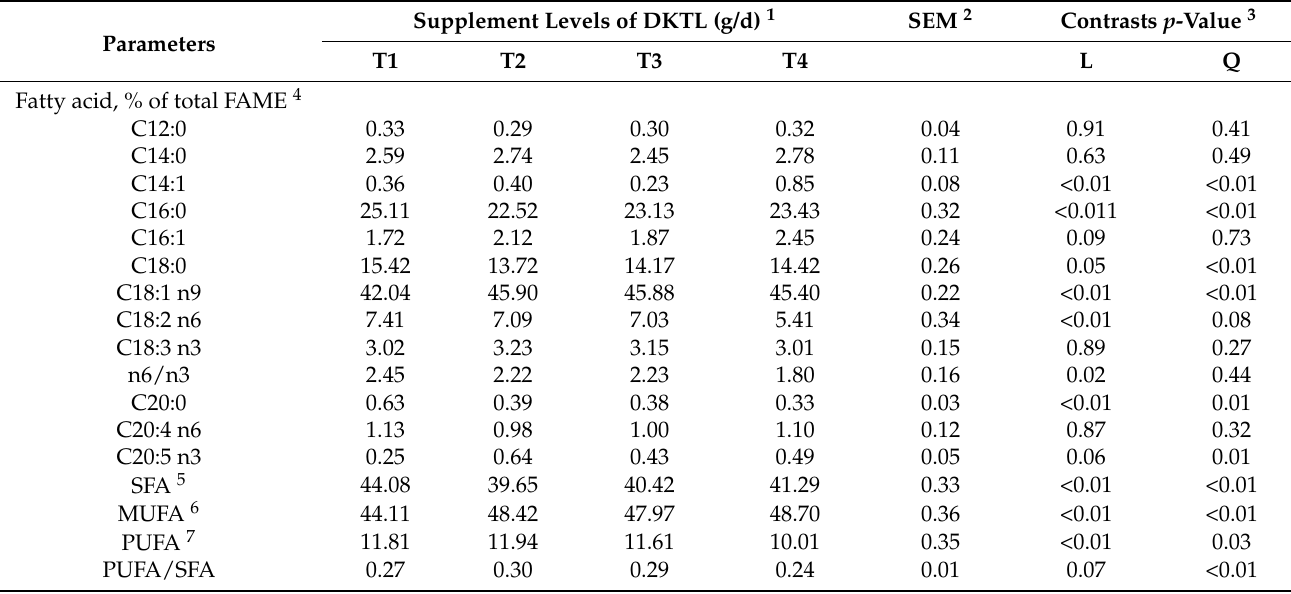
Table 7. Effects of Kratom leaves supplement on fatty acid (FA) profiles (% of total FA) in Longissimus dorsi muscle of fattening